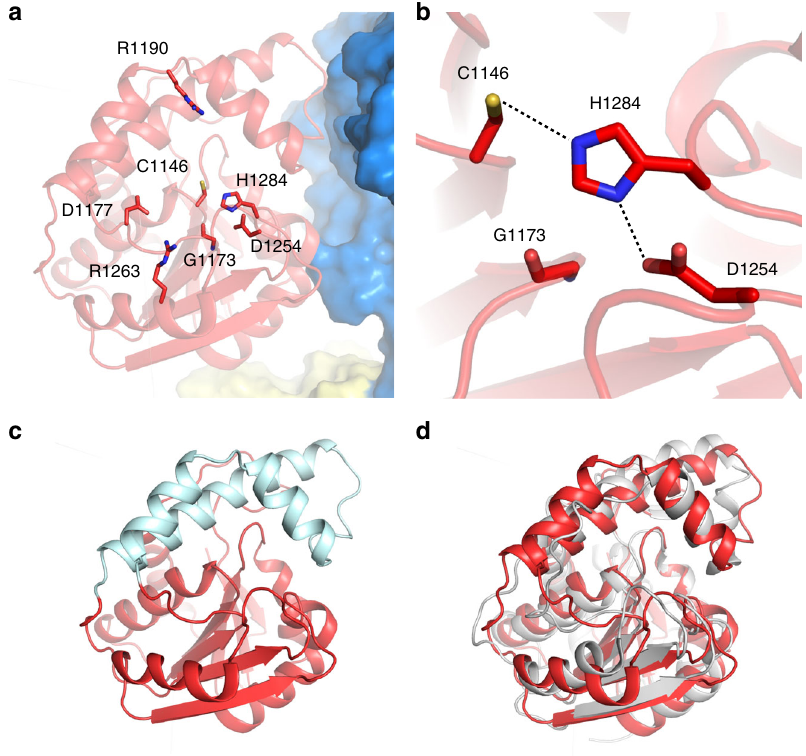
Fig. 5 Structure of ObiF1 TE domain. a The ObiF1 TE domain (red) is adjacent to the C domain (blue); active site residues that were targeted for mutation are highlighted. b Catalytic triad residues Cys1146, His1284, and Asp1254. In ObiF1, Gly1173 occurs at the β -strand 5 position where the aspartic acid residue is typically found in the His-Asp dyad of EntF-like TE domains. c The ObiF1 TE domain (red) contains a three-helix lid-loop region (cyan). d ObiF1 TE domain (red) is superimposed with the RifR type II TE domain (3FLB; gray) using